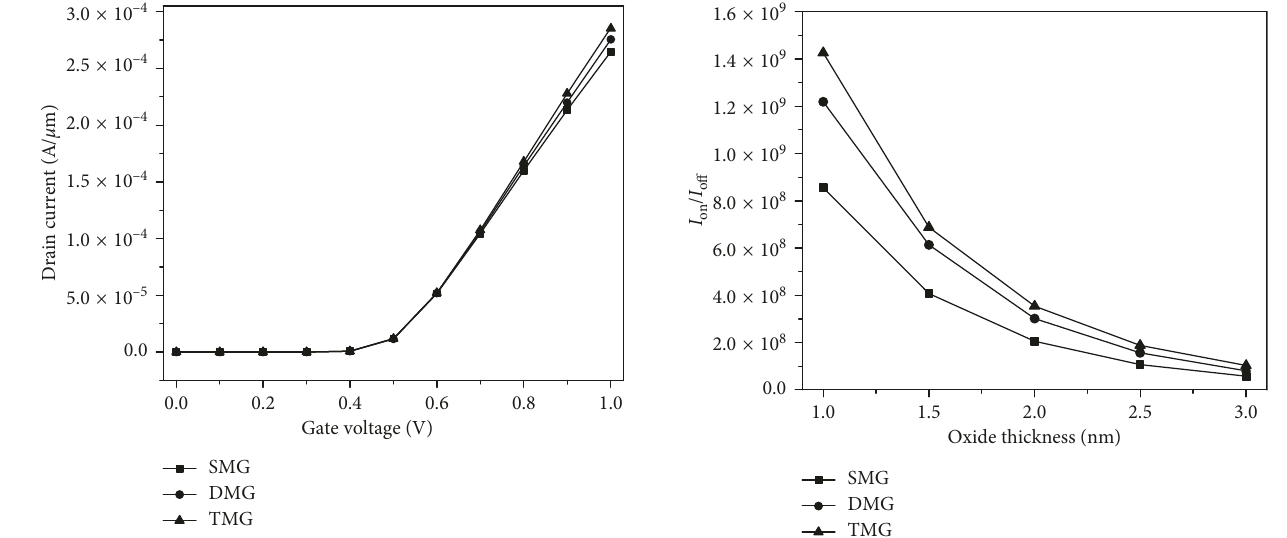
Figure 8: Drain current versus gate voltage for SMG, DMG, and TMG Re-S/D SOI MOSFET.